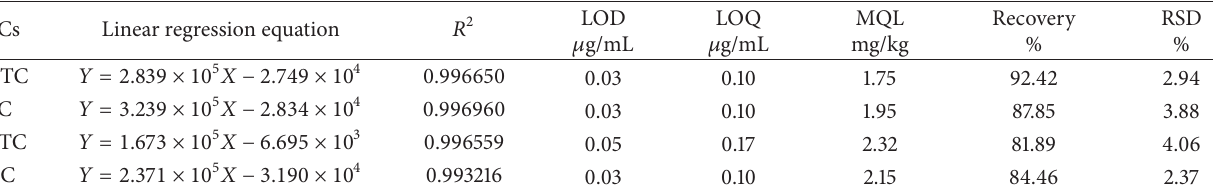
Table 4: Figures of merit for TCs using the proposed UAE ∗